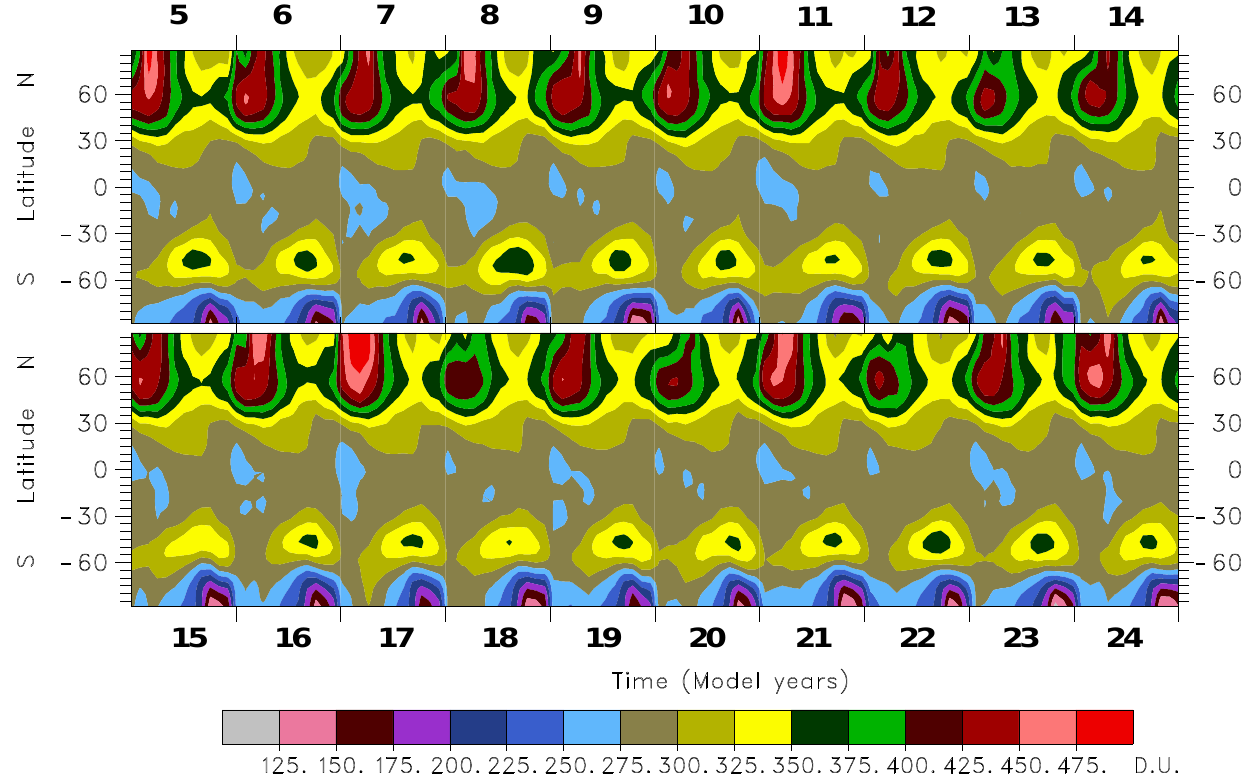
Fig. 7. Temporal evolution of modeled zonal mean total ozone (Dobson Units) over 20 simulated years.